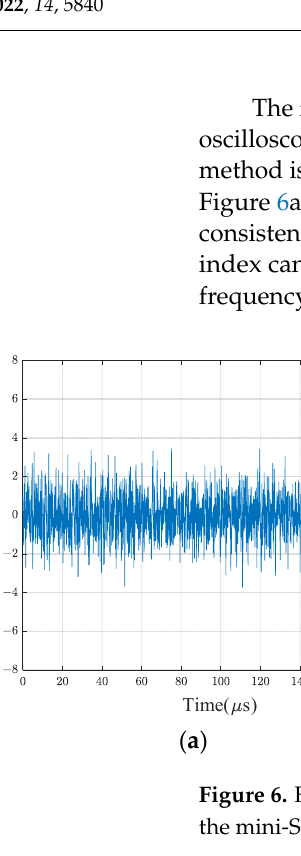
( b ) Figure 8. Results of range profile and azimuth profile. ( a ) Range profile. ( b ) Azimuth profile. Summarizing the above discussion, the design of the LFM signal generator starts with the establishment of a mathematical model for PLL. By simulating and measuring the phase-locked loop, the loop parameters are iteratively optimized, and a small fre- quency error and frequency nonlinearity are obtained. Finally, good pulse compression performance is achieved in both range and azimuth directions. 3.3. Active Phased Array Antennas The proposed W-Band one-dimension phased array antenna requires angle scanning of 15° in elevation (range), and the side lobe in elevation is no more than − 15 dB. This indicates that the antenna needs to have the advantages of low sidelobe and high effi- ciency. Meanwhile, the spacing of the W-Band antenna unit is small (only about 1.5 mm), which also brings difficulties to the integration. All these are difficult problems to be solved in this paper.